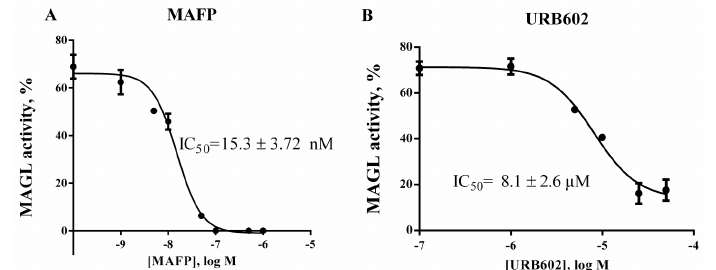
Figure 4. After incubation of h MAGL with the inhibitor, 1c was rapidly added and fluorescence read for 30 min. The activity of h MAGL was calculated as described for the kinetic assay. IC 50 for URB602 was found to be 8.1 µ M, which is in line with literature data [20]. As already known, MAFP had the lowest IC 50 value, our experiments gave an IC 50 of 15.3 nM, which is in the range of values indicated in literature [12,20].